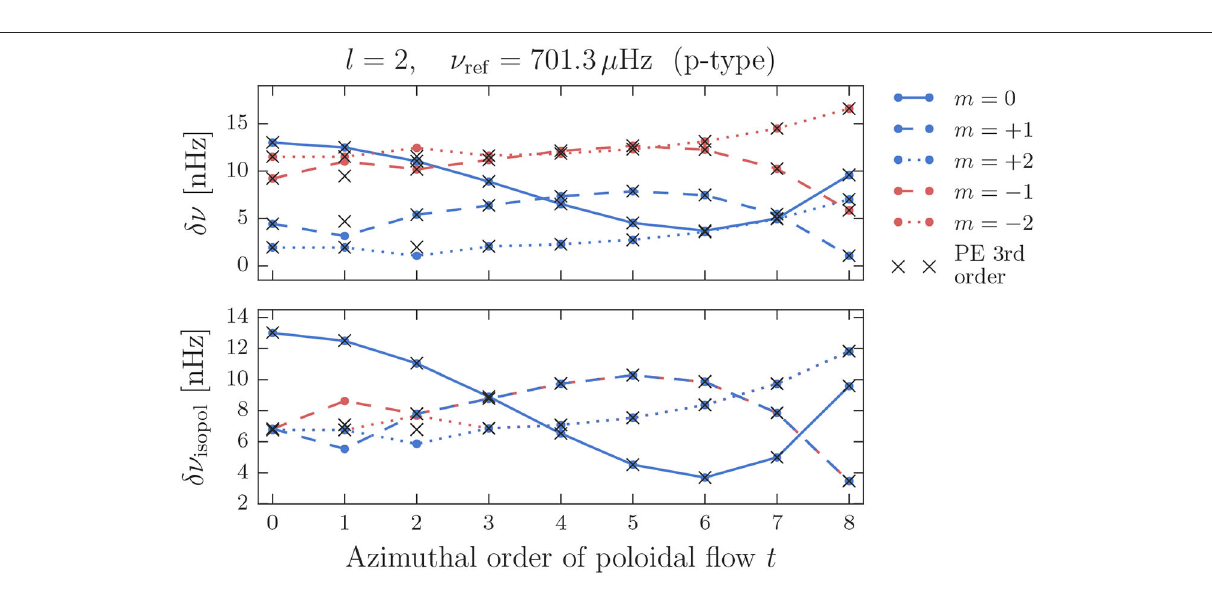
FIGURE 8 | Frequency shifts for the p-type l 2 multiplet at 701.3 µ Hz in the co-rotating frame. (Upper) Shifts resulting from rotation combined with a poloidal flow = of s 8 and different values of t . (Lower) Isolated frequency shifts of the poloidal =